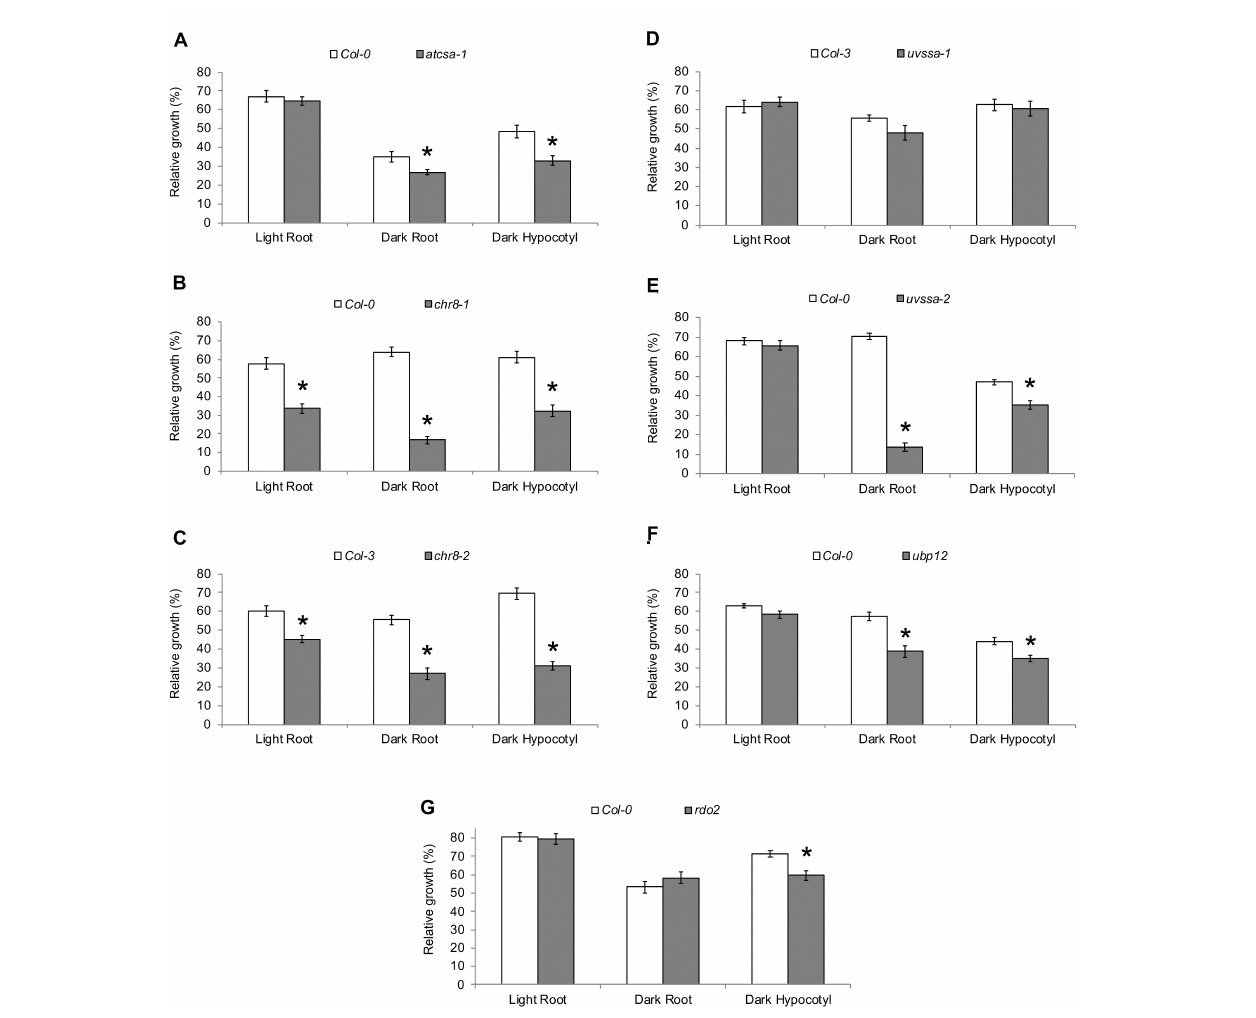
FIGURE 4 | UV tolerance of mutants in TCR genes. Relative growth of roots and hypocotyls of (A) atcsa-1 , (B) chr8-1 , (C) chr8-2 , (D) uvssa-1 , (E) uvssa-2 , (F) ubp12 , and (G) rdo2 after 1000 J m − 2 UV treatment, followed by 2 days of long-day (light) or dark incubation. Data are expressed as length relative to unirradiated control of the same genotype. Values are means ± SE ( n = 20), ∗ p ≤ 0.05 of mutants vs wild